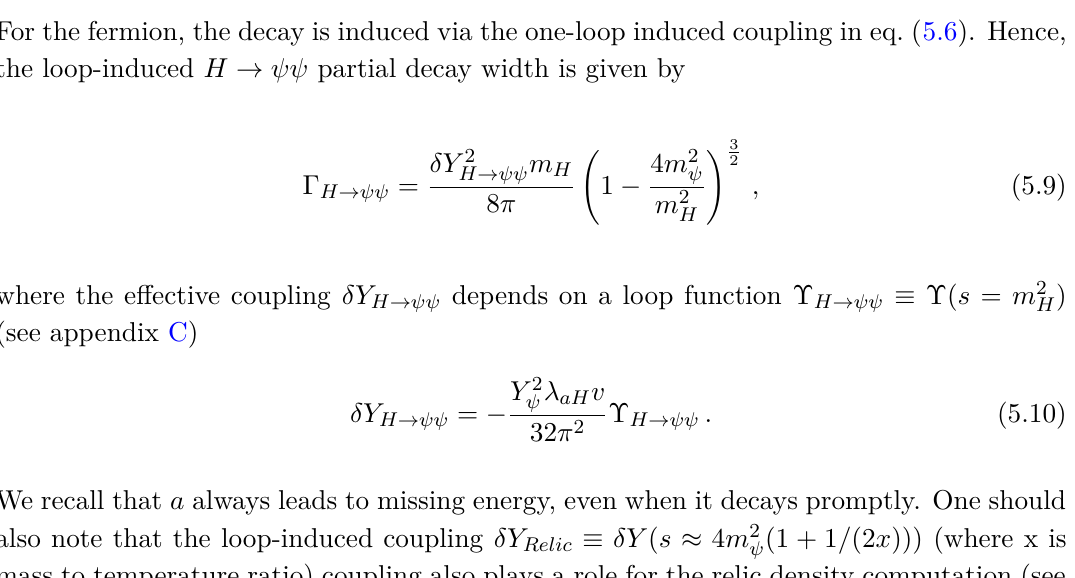
For the fermion, the decay is induced via the one-loop induced coupling in eq. (5.6).